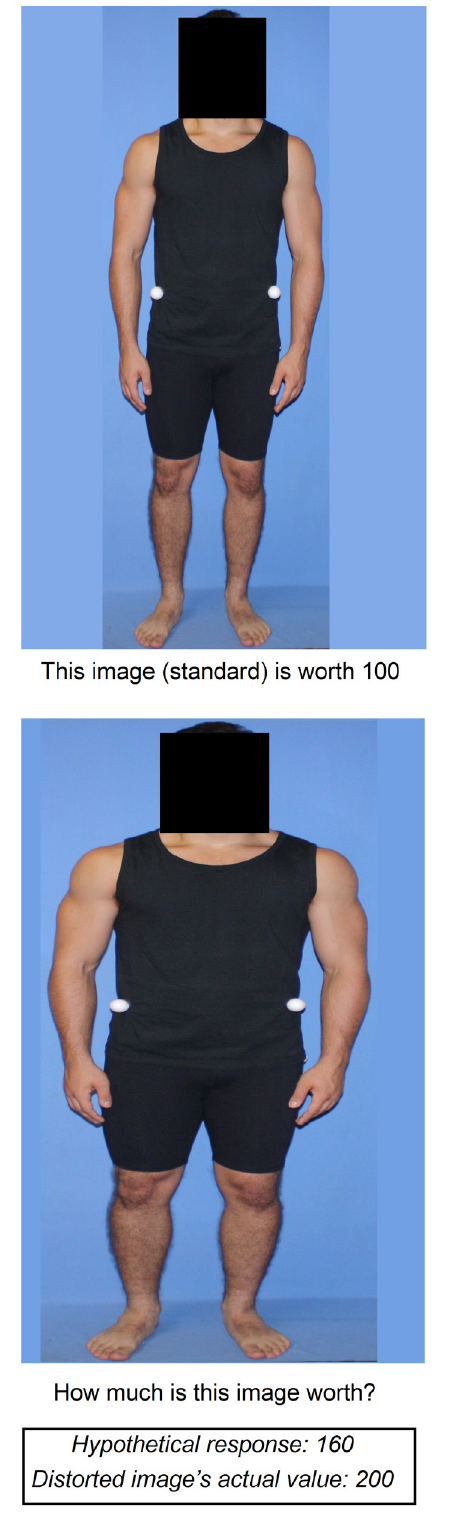
Figure 2. Pair of two images of a participant’s body, undistorted (100% or BMI = 26.7, top) and distorted (200% or BMI = 40, bottom).